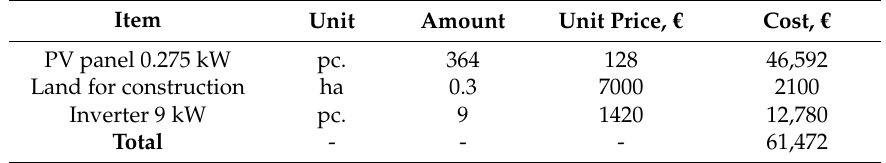
Table 5. Investment outlays of a photovoltaic system with Li-Ion battery energy storage (Scenario 2) [25,33,34,37,49].